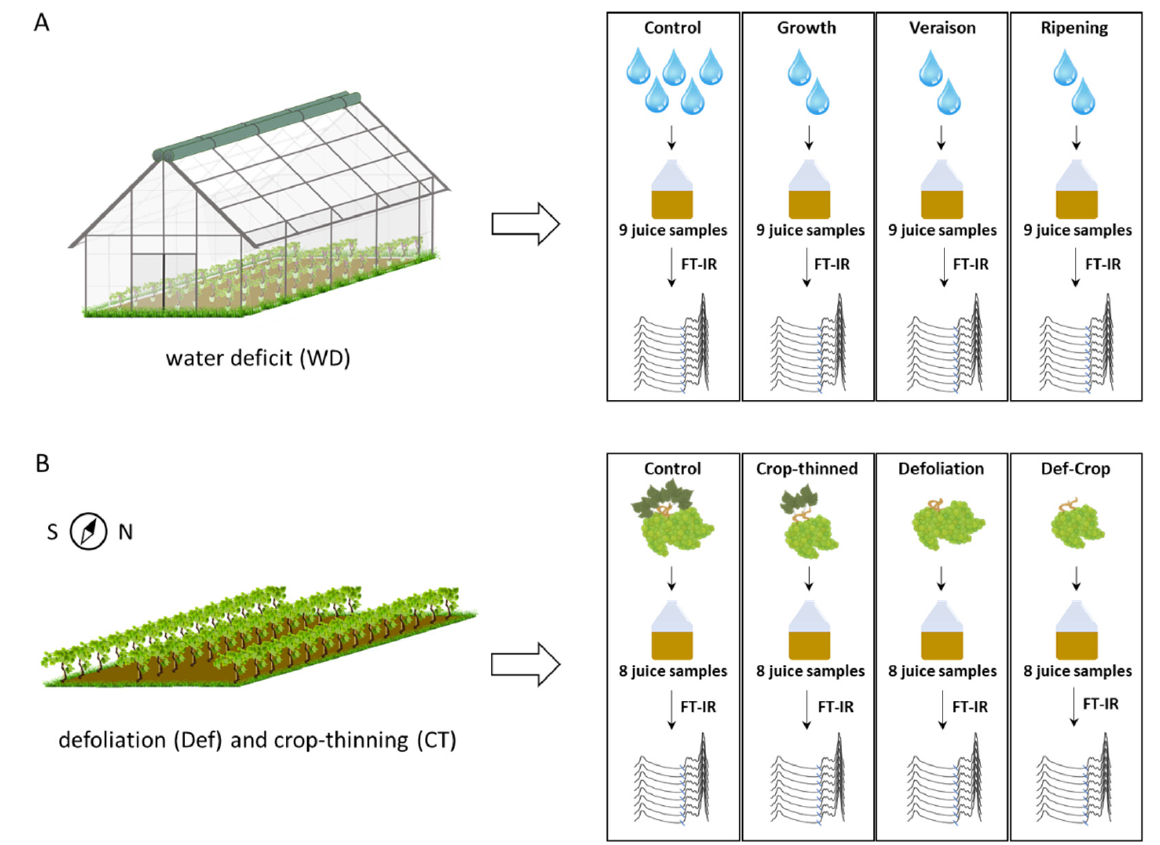
Figure 1. Experimental design. The experiment consisted of two independent trials, one performed in an open screenhouse ( A ) and the other in a conventional field vineyard ( B ) (Pictures S1 and S2). The open screenhouse trial was based on water deficit (WD) studies while the field study looked at the effects of viticultural practices, namely defoliation (Def) and crop reduction (CT). Juice samples (8 per treatment in the vineyard and 9 per treatment in the open screenhouse) were produced from grapes collected from both experiments and then analyzed by Fourier Transform-Infrared Spectroscopy (FT-IR, WineScan, FOSS Analytical A/S, Hillerød,